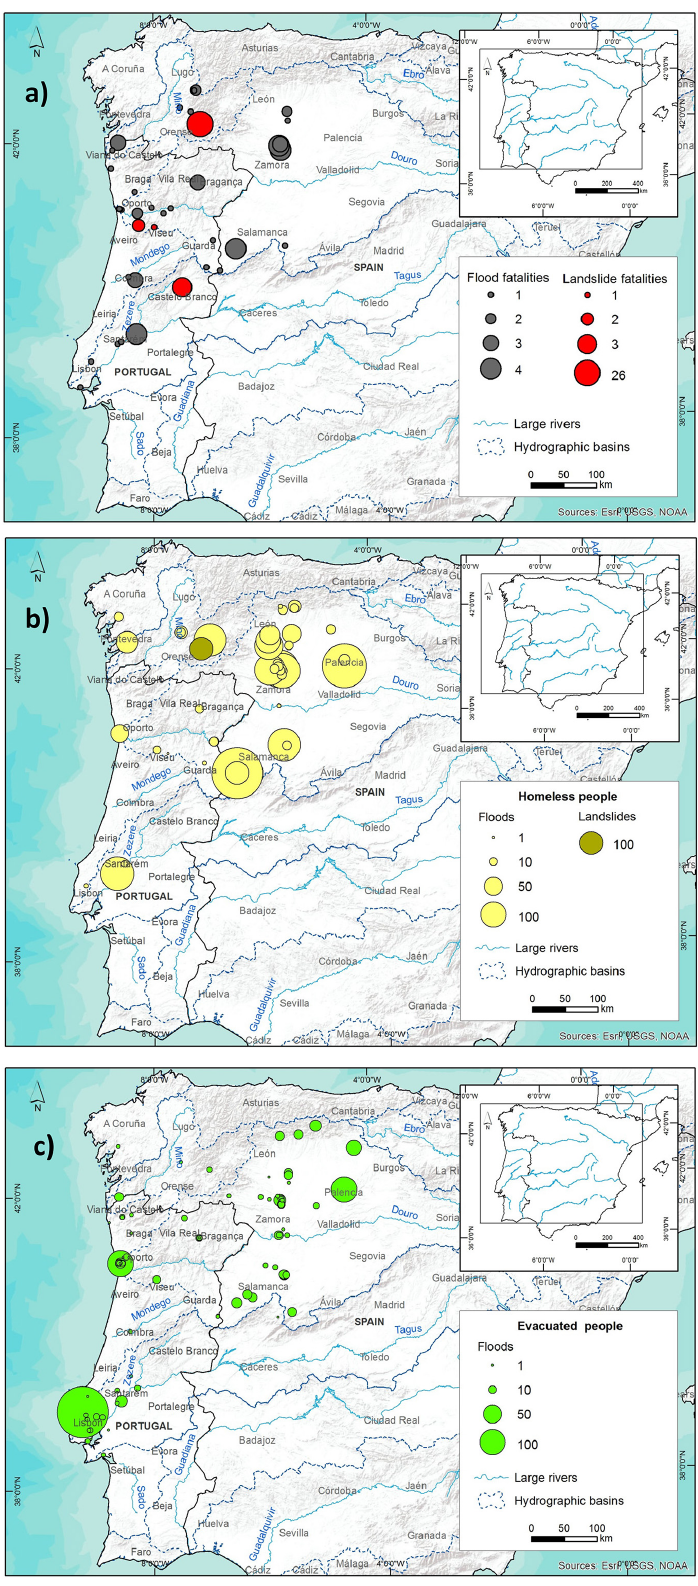
Figure 3. Social consequences of the DISASTER cases: fatalities (a) , homeless people (b) , and evacuated people (c)